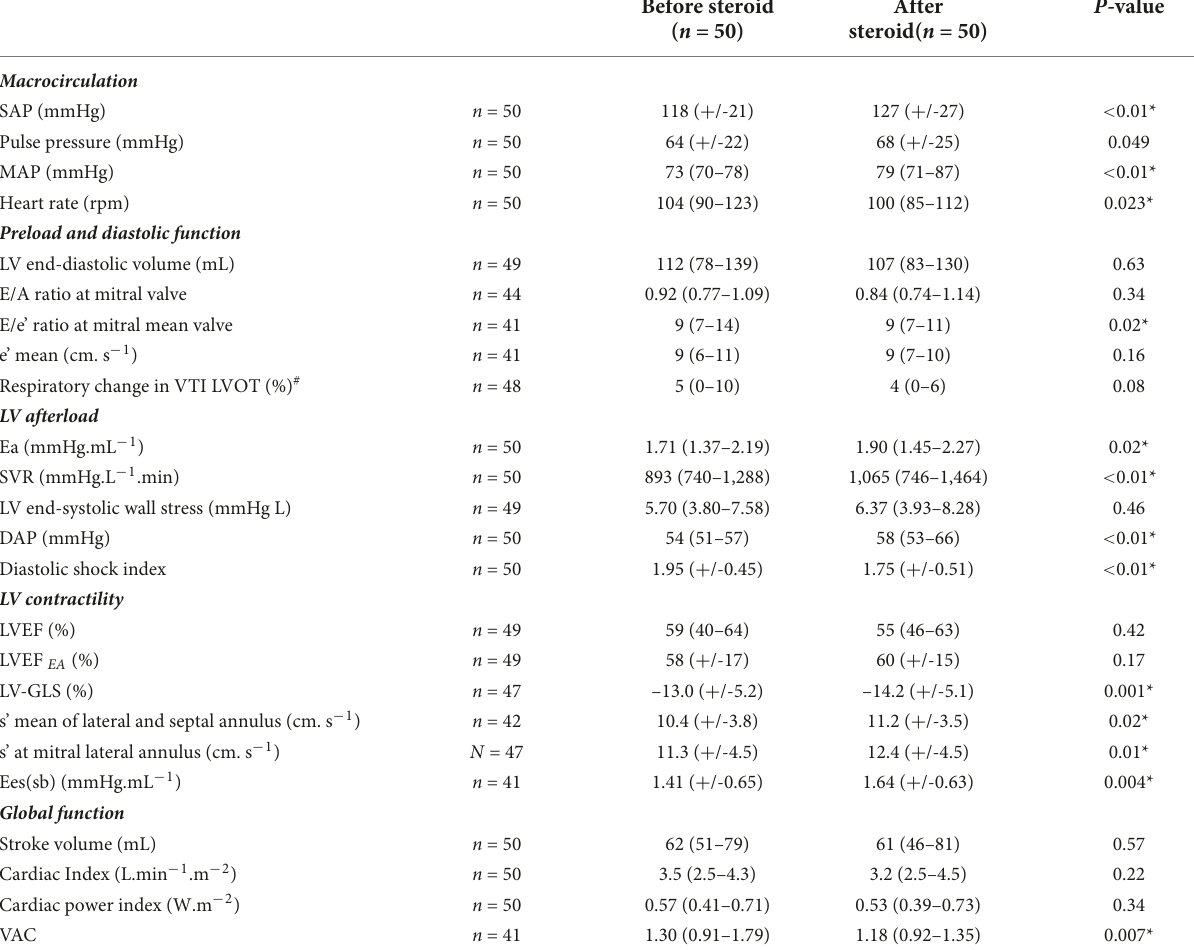
TABLE 2 Evolution of hemodynamic and echocardiographic parameters in septic shock patients before and after initiation of low-dose steroid therapy.